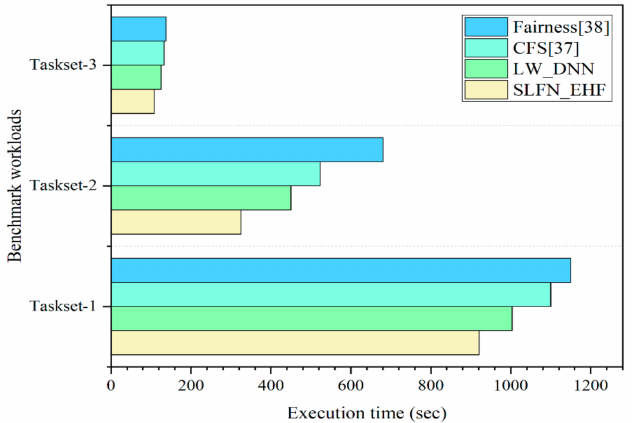
Figure 12. Normalized Execution time observed for Benchmark Workloads on Hardware Configuration